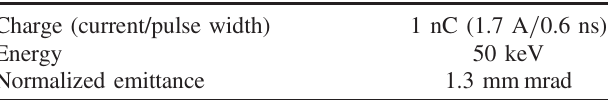
TABLE I. Main beam parameters at the 50-kV thermionic-gun exit obtained with CST